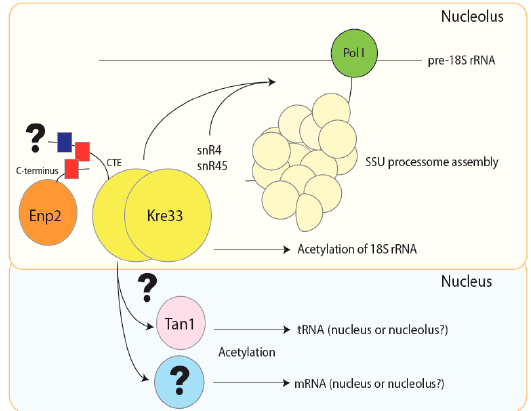
Figure 4. Hypothetical model for Kre33 acetylation of RNAs. In the nucleolus, the Kre33 homodimer and Enp2 protein may interact together via their C-terminal coiled-coil motifs (in red) before joining the SSU processome. In this particle, Kre33 catalyzes the acetylation of two 18S rRNA cytosines: each modification is guided by a different box C/D small nucleolar RNA (snoRNA), snR4 (C1280 in helix 34) and snR45 (C1773 in helix 45). Acetylation of tRNAs and mRNAs could occur in the nucleoplasm, where Kre33 needs to interacts with the adaptor protein Tan1 in order to acetylate tRNAs. It is not known if acetylation of mRNAs requires adaptor protein(s). Nevertheless, it remains possible that acetylation of tRNAs and mRNAs could take place in the nucleolus since tRNAs and mRNAs have previously been detected in this compartment [51,54,91,92].